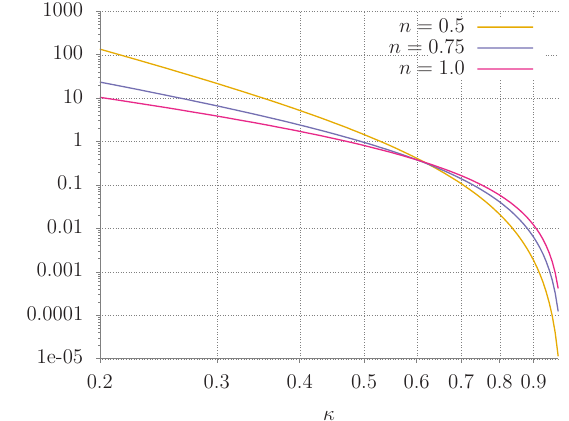
Figure 2: Evaluation of the integral in Eq. (7) as function of κ and for three different values of n